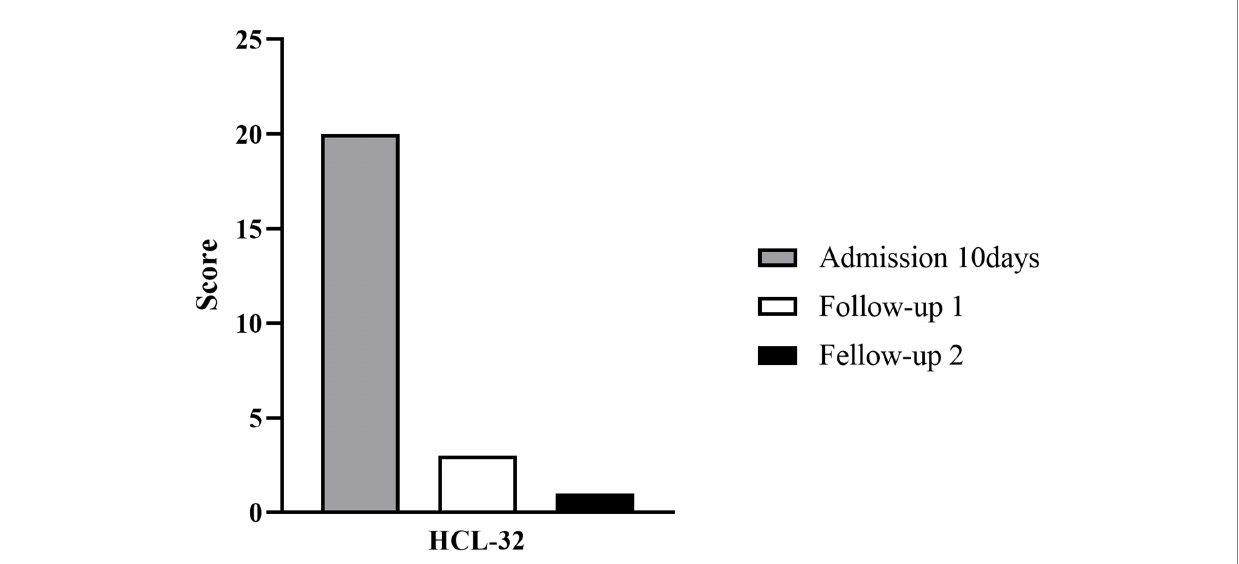
FIGURE 4 Histogram depicting score changes on HCL-32 at three time points. HCL-32: 32-item hypomania checklist. Admission 10 days: May 26, 2020; Fellow- up 1 and 2: June 23, 2020 and August 15, 2020,